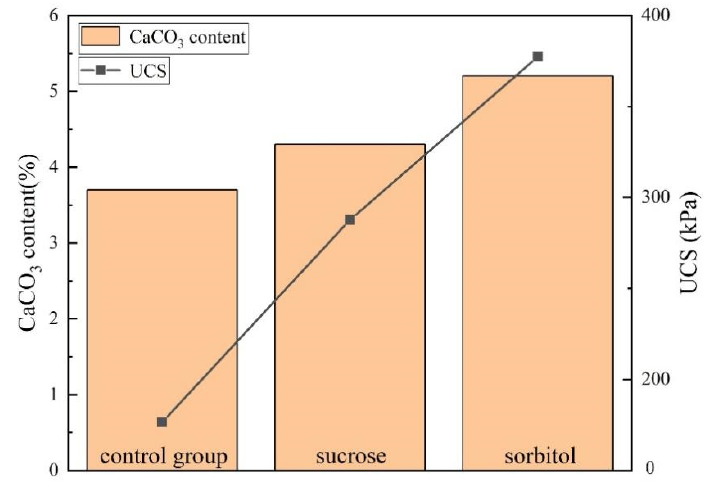
Figure 8. The relationship between CaCO 3 content and UCS.